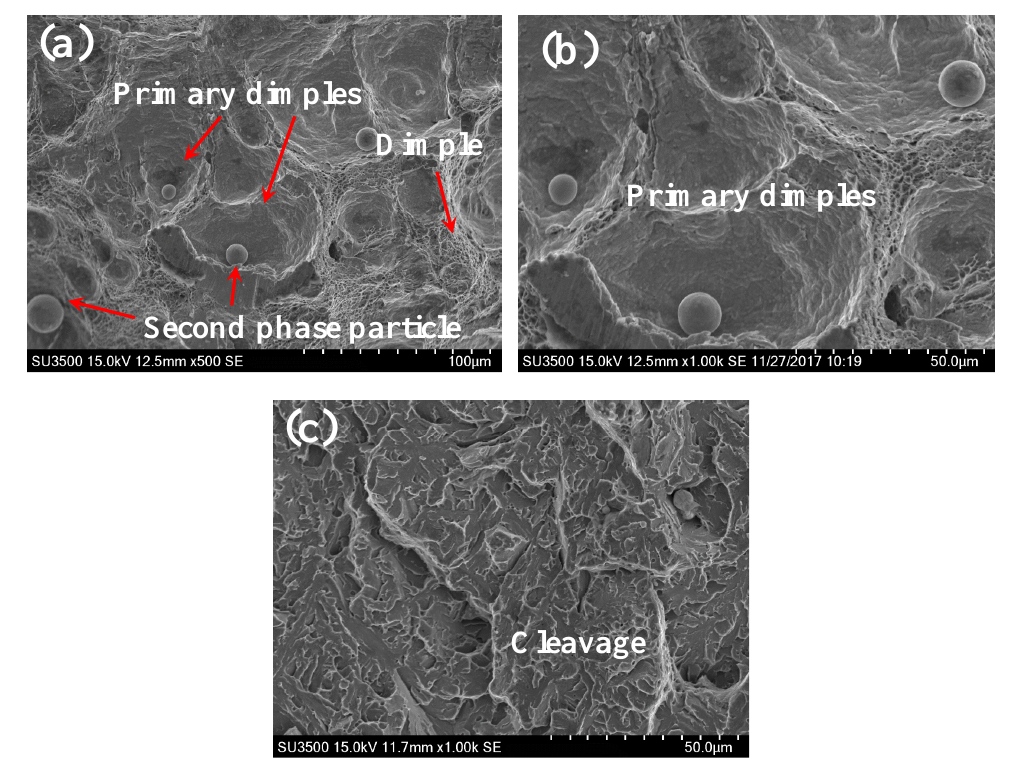
Figure 7. The microscopic fracture surface under HF condition: ( a , b ) BM and ( c ) WM. ( b ) is the magnification of primary dimples in ( a ).